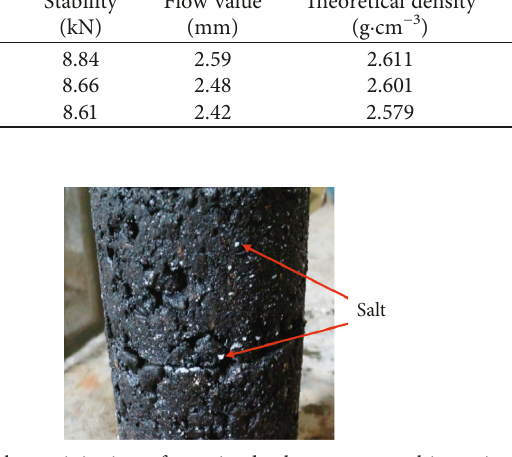
Figure 4: Surface salt precipitation of sustained-release snow melting mixture